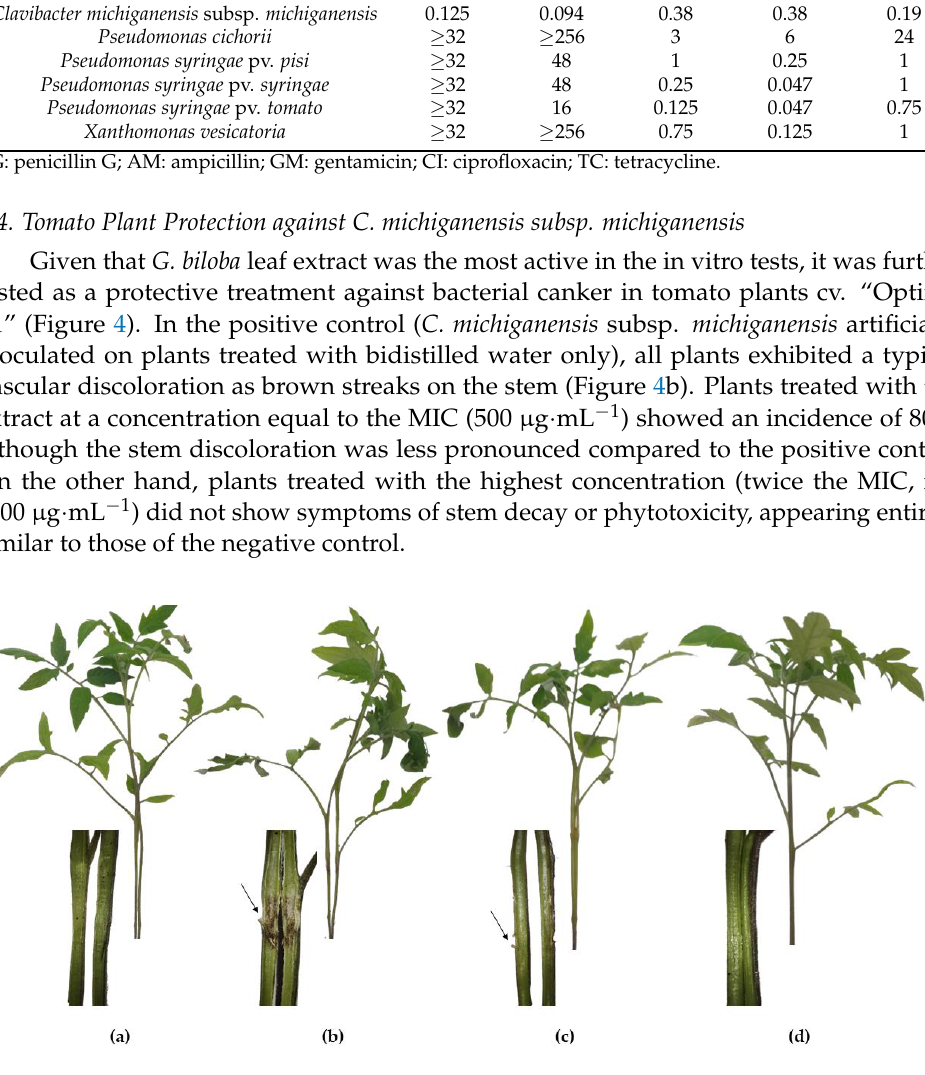
Figure 4. Symptoms of bacterial canker produced by C. michiganensis subsp. michiganensis in plants of tomato cv. “Optima F1” after 10 days of inoculation: ( a ) negative control; ( b ) positive control; ( c ) G. biloba leaf extract at 500 μg∙mL −1 ; and ( d ) G. biloba leaf extract at 1000 μg∙mL −1 .